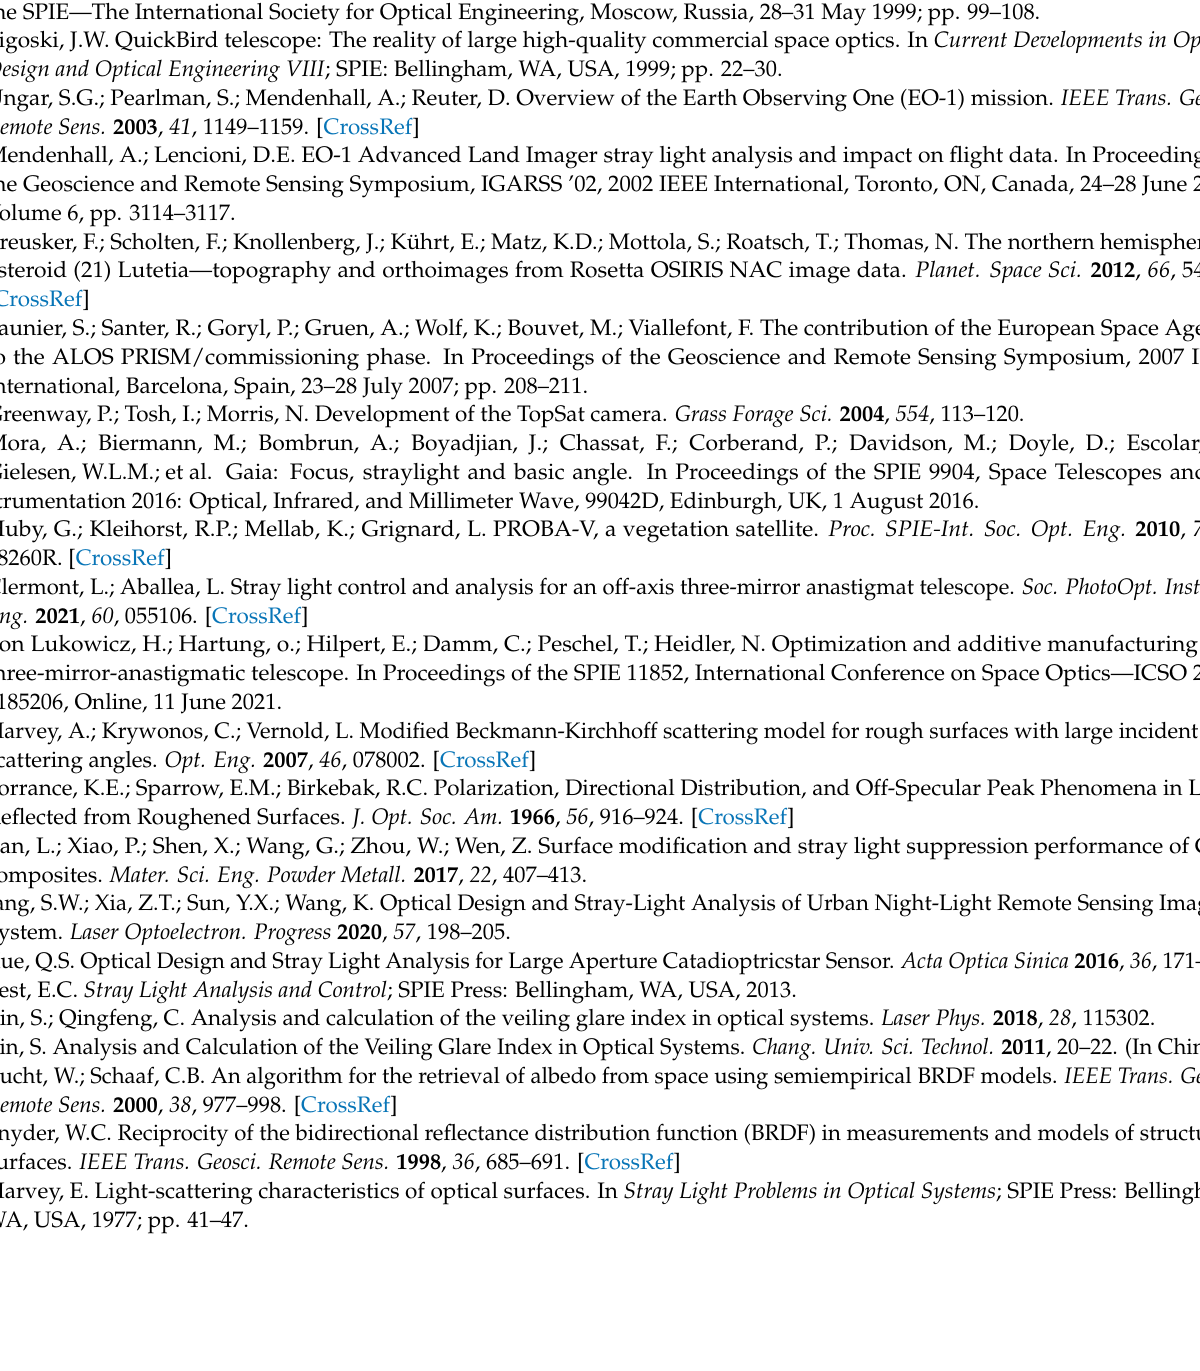
Figoski, J.W. Alignment and test results of the QuickBird telescope using the Ball Optical System Test Facility. In Proceedings of Figoski, J.W. QuickBird telescope: The reality of large high-quality commercial space optics. In Current Developments in